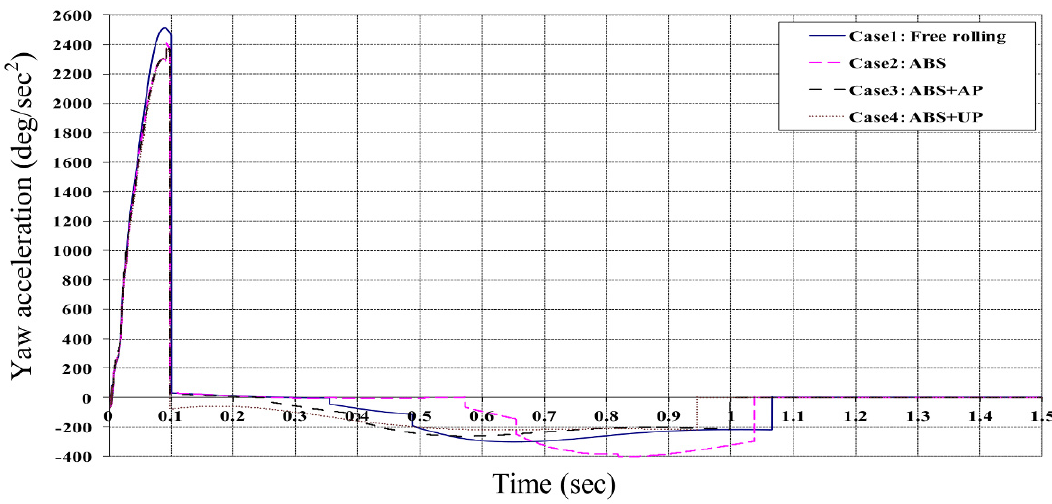
Figure 23. Yaw acceleration of the vehicle body for all cases at offset collision and speed of 70